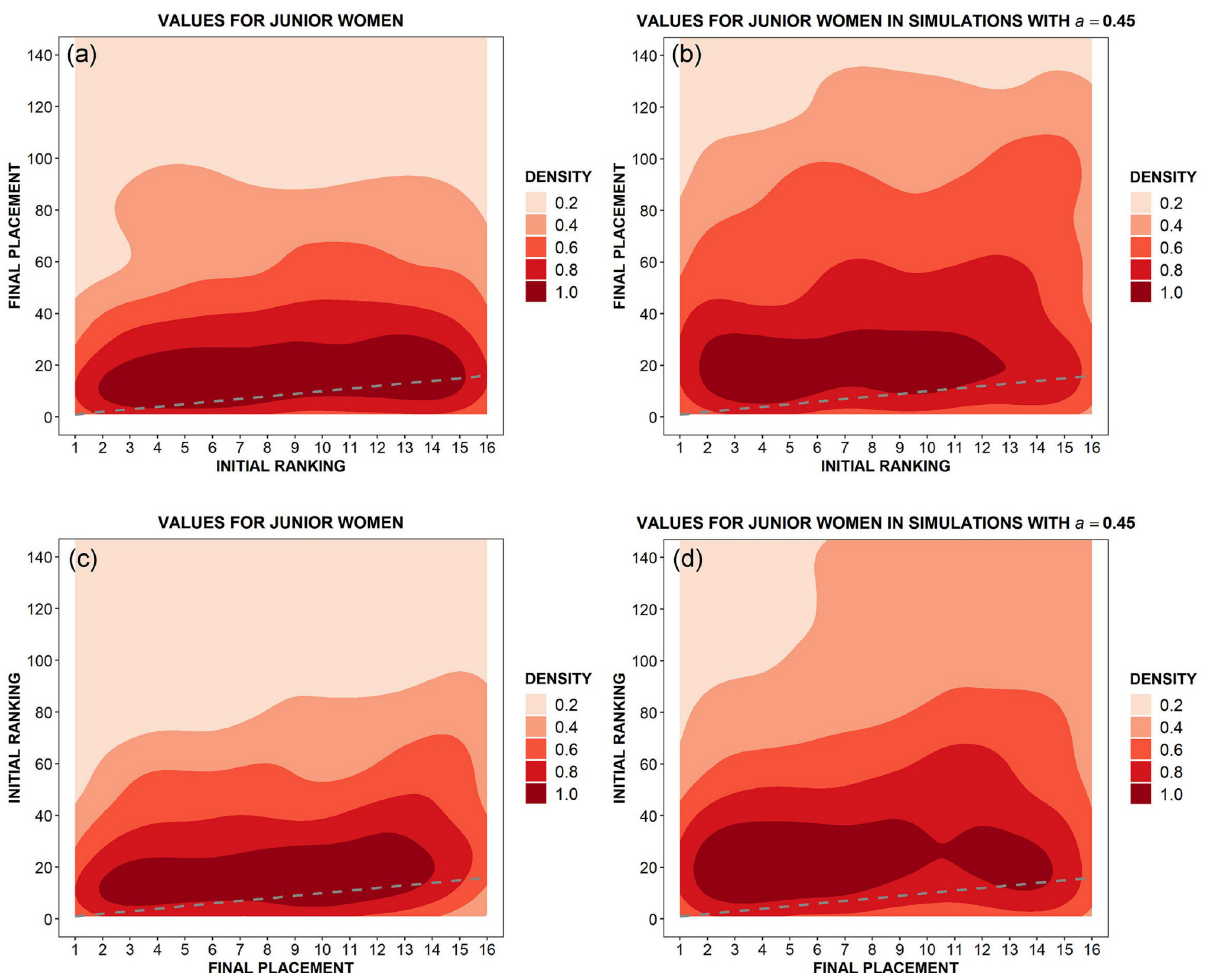
Fig 7. Single tournaments: Kernel density plots for initial ranking position versus final classification (top panels) and vice-versa (bottom panels) in both World Cups (a-c) and simulations (b-d) for female fencers. In every panel, a dashed gray line shows the ideal case in which talent would be the only variable influencing both ranking positions and tournaments’